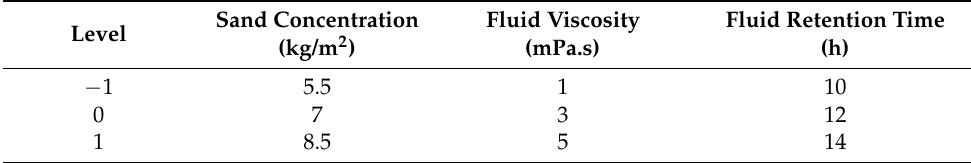
Table 3. Results of the response surface test.